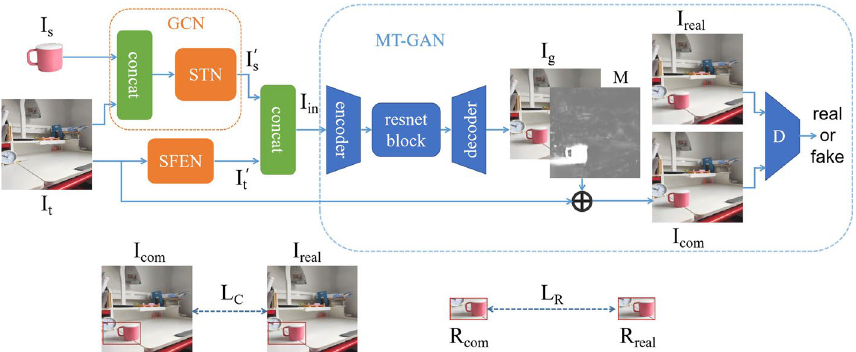
Fig. 1 The architecture of our multitask GAN for image composition based on spatial features